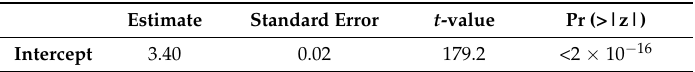
Table 2. Parameters of Intercept of the fitted Generalized Additive Model (GAM) between species richness and topographic variables.